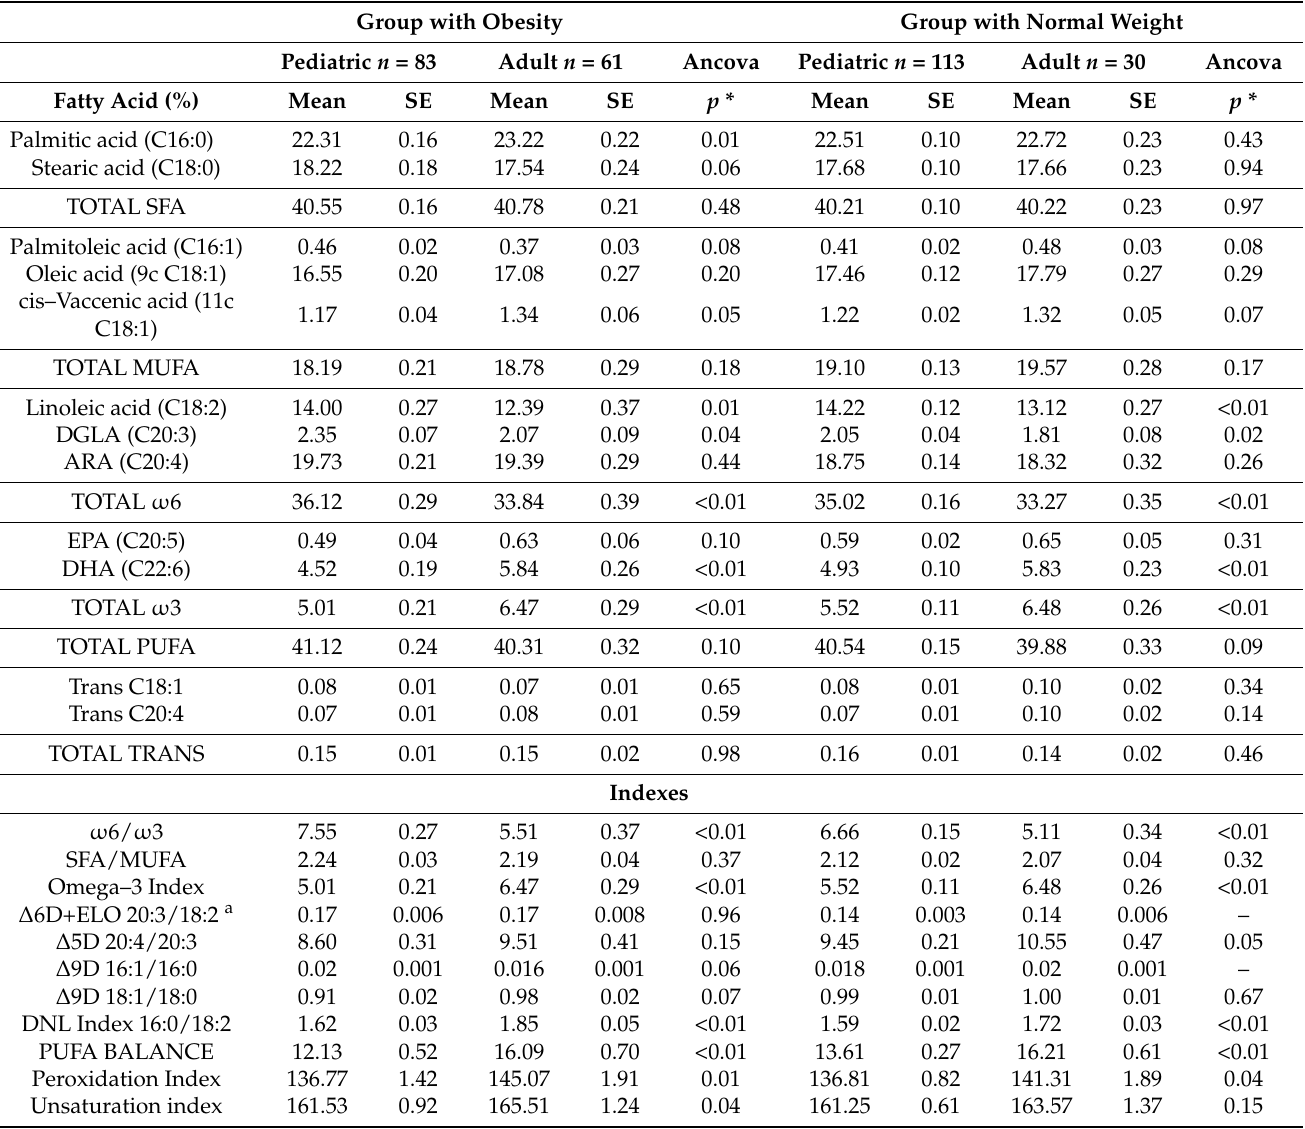
Table 1. Red blood cell ( RBC) membrane fatty acid profile. Group with Obesity Group with Normal Weight Pediatric n =